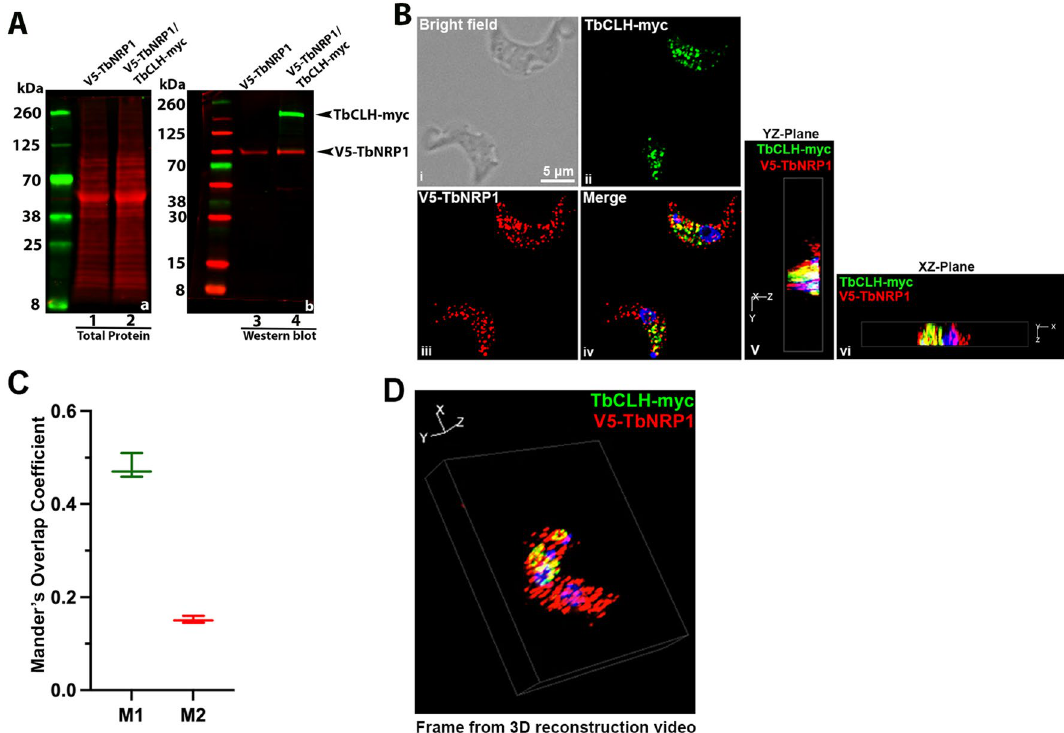
Figure 5. Clathrin Colocalizes with TbNRP1 ( A ) Western blot analysis of myc tag in V5-TbNRP1/TbCLH-myc cell line. Trypanosomes (2 × 10 6 ) were lysed, and proteins were separated by SDS-PAGE (12%). Polypeptides were transferred to a PVDF membrane. The membrane was probed with anti-V5 (rabbit) or anti-myc (mouse) primary antibody and developed using goat anti-rabbit IR Dye 680 or goat anti-mouse IR Dye 800 (LI-COR) secondary antibody for near-infrared based fluorescence detection. ( B ) Detection of CLH-myc and NRP1. Cells were fixed in PFA and stained using anti-V5 (rabbit) and anti-myc (mouse) antibodies. DAPI was used to stain DNA. (i) (ii) and (iii) represent bright field, CLH-myc and V5-NRP1 locations respectively, and (iv) is a merged fluorescence image of TbCLH-myc and V5-TbNRP1. Panels (v) and (vi) are merged images in different planes (XY, XZ). ( C ) Box and Whisker plot of overlap analysis (Mander’s coefficient) between CLH-myc and V5-NRP-1. M1 is the extent of overlap between CLH-myc and NRP1, whereas M2 is degree of overlap between NRP1 and CLH-myc. A total 300 cells from three independent biological experiments were analysed. ( D ) A frame from 3D reconstruction video (see Video 2). K, Kinetoplast; N,